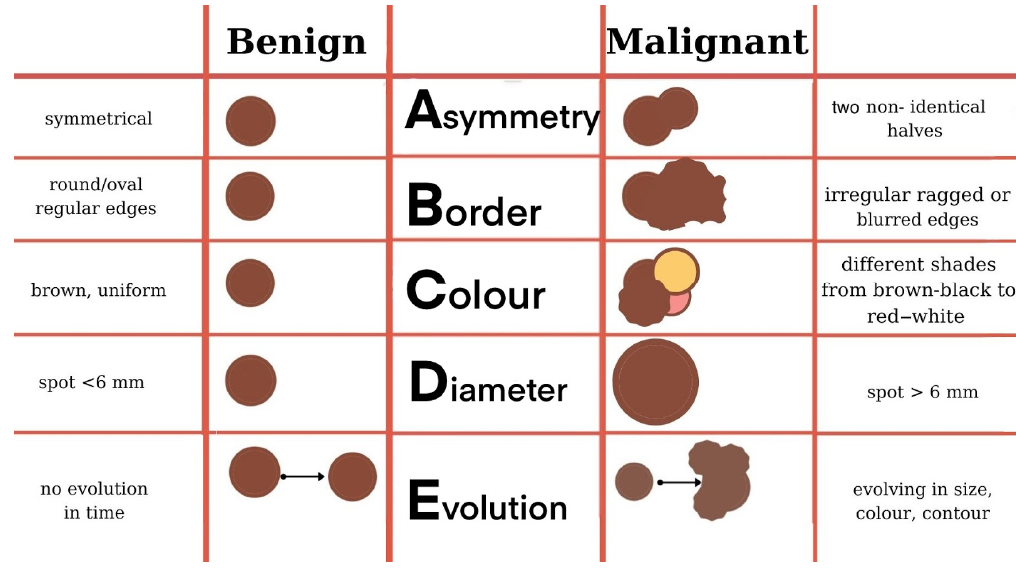
Figure 2. ABCDE evaluation of a pigmentary skin lesion [64].